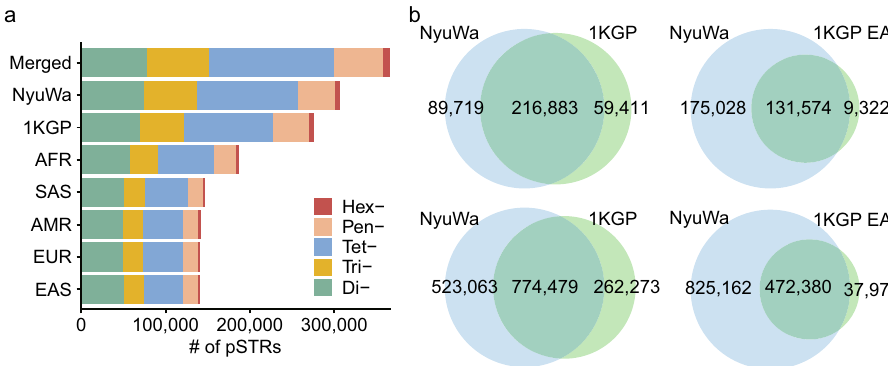
identi fi ed from the 1KGP dataset (left) and the East Asian samples in the 1KGP dataset